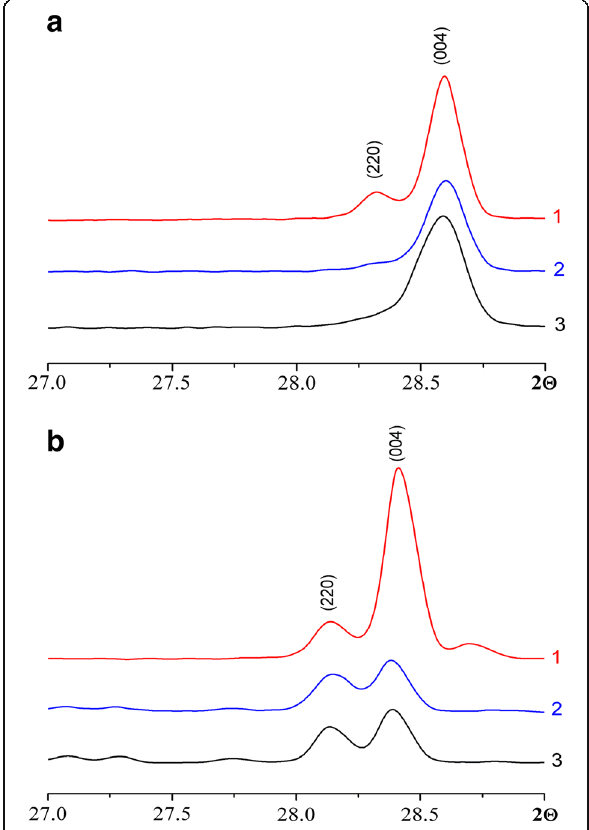
Fig. 5 XRPD pattern of peaks 220 and 004 of CH 3 NH 3 PbI 3 films deposited on the glass substrate ( a ) and on the FTO ( b ) at 85 °C at different ratios of the starting reagents PbI 2 and CH 3 NH 3 I: 1:1 (1); 1:2 (2); 1:3